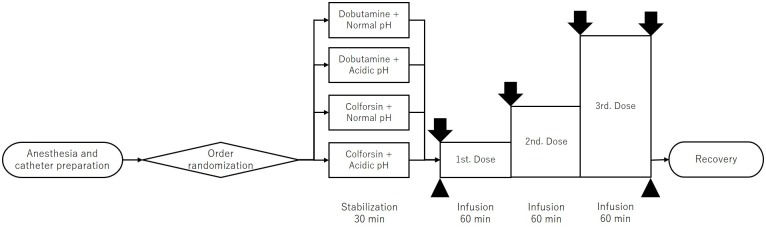
Time course of study regimen.After anesthesia and catheter preparation, four experimental sequences were randomized using a random number table, and then the dogs were stabilized for 30 min in each condition. Colforsin (1st. Dose: 0.3 μg/kg/min, 2nd. Dose: 0.6 μg/kg/min, 3rd. Dose: 1.2 μg/kg/min) and dobutamine (1st. Dose: 5 μg/kg/min, 2nd. Dose: 10 μg/kg/min, 3rd. Dose: 20 μg/kg/min) were infused 60 min. Cardiovascular parameters were measured at baseline and the end of each increment dose. The arrow indicates the measurement of cardiovascular parameters. The arrow-head indicates the measurement of blood gas and biochemical test.